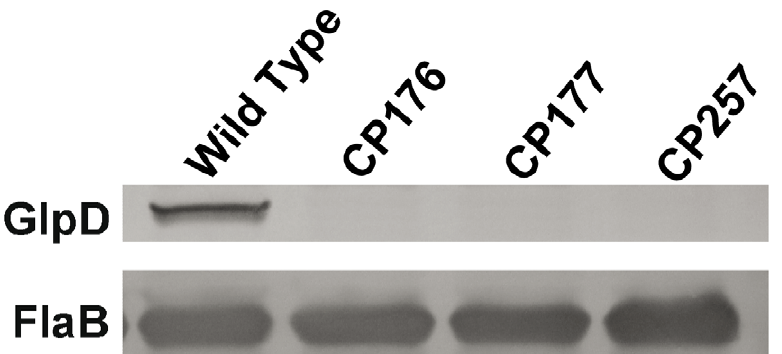
Figure 9. GlpD is absent in disruption mutants. Whole cell lysates from B31-A3, CP176, CP177, and CP257 were separated by SDS-PAGE, followed by immunoblot analysis using GlpD-specific antiserum. Presence of FlaB was also measured as a control.